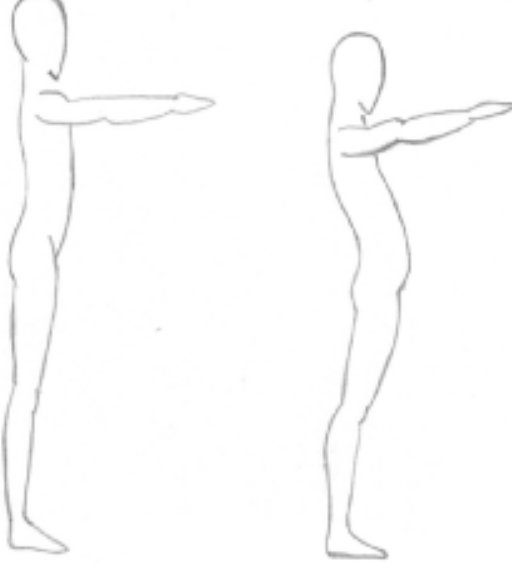
Matthiass-test. Left side shows departure position. Right side shows one of the possible compensa- tory